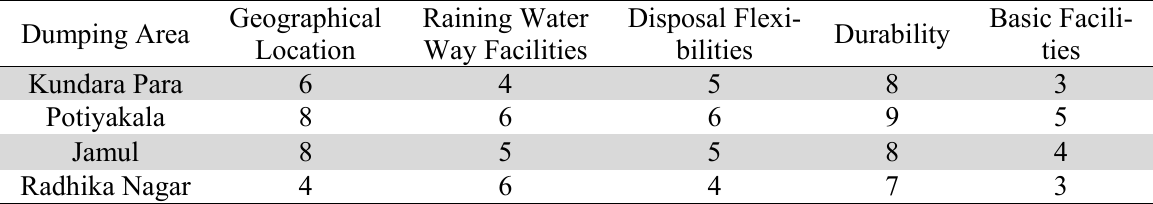
Pertinent evaluation attributes for